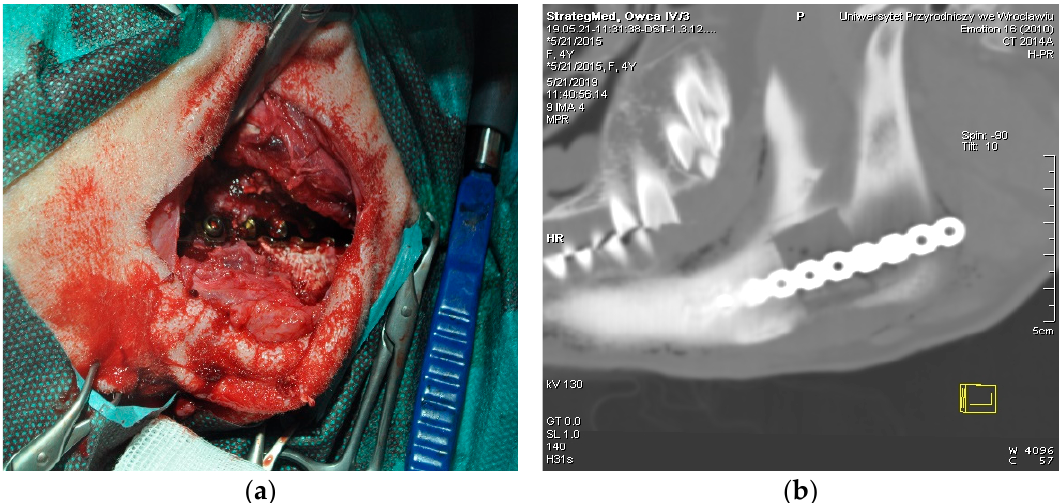
Figure 2. Procedure of scaffold implantation. ( a ) Surgical wound showing titanium bone plate attached with srews. ( b ) CT image of the scaffold placed in the ovine mandible.